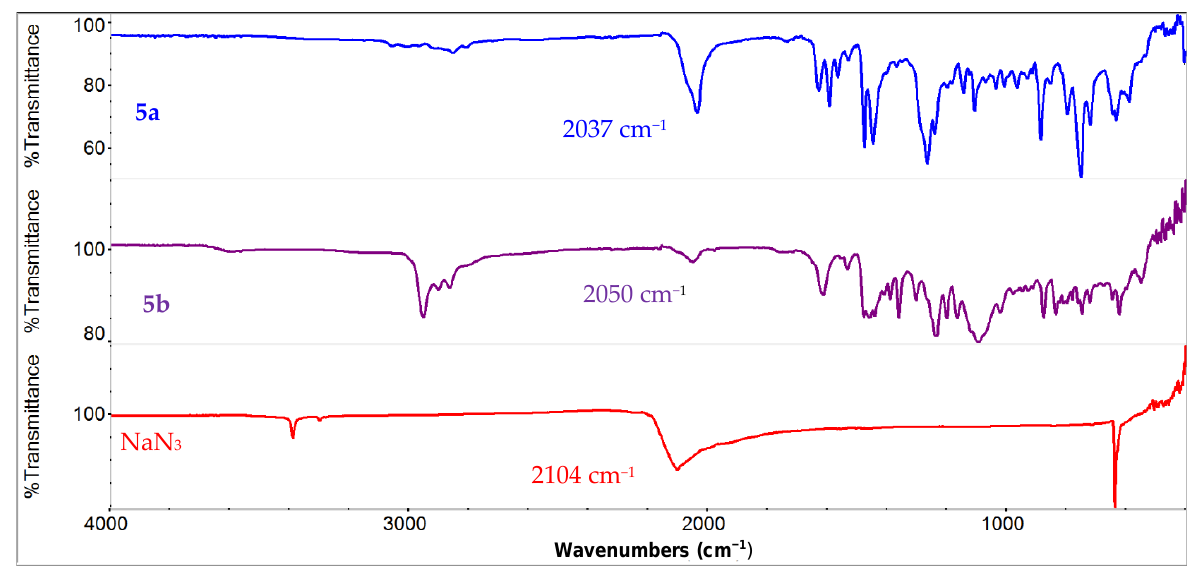
Figure 1. Comparison of FT - IR spectra of (salan)Mn(N 3 ) ( 5a ) ( top ), (salan - t Bu 2 )Mn(N 3 ) ( 5b ) ( middle ), and NaN 3 ( bottom ).